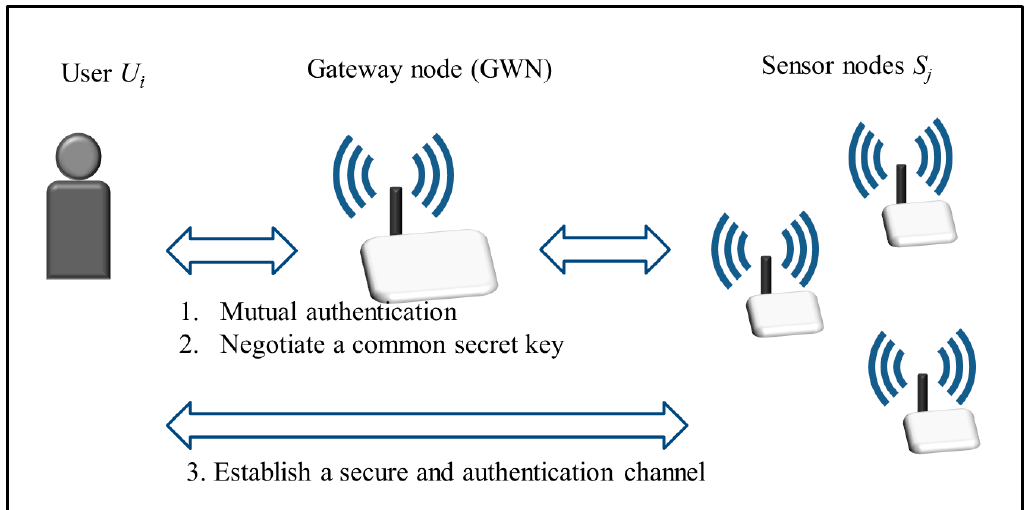
Figure 1. An authentication and key agreement scheme for WSNs.